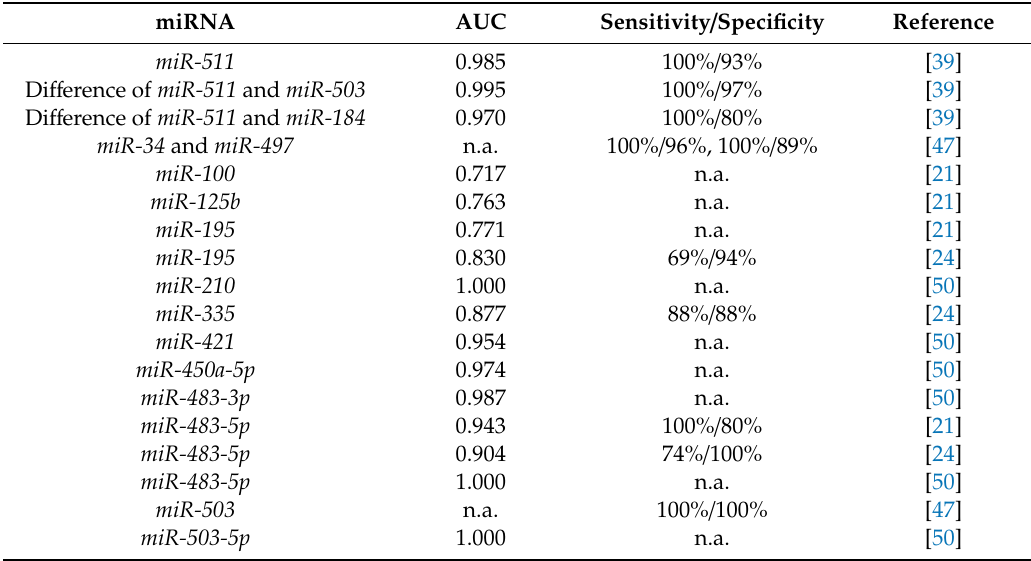
Table 2. Diagnostic accuracy of di ff erentially expressed miRNAs in tissue